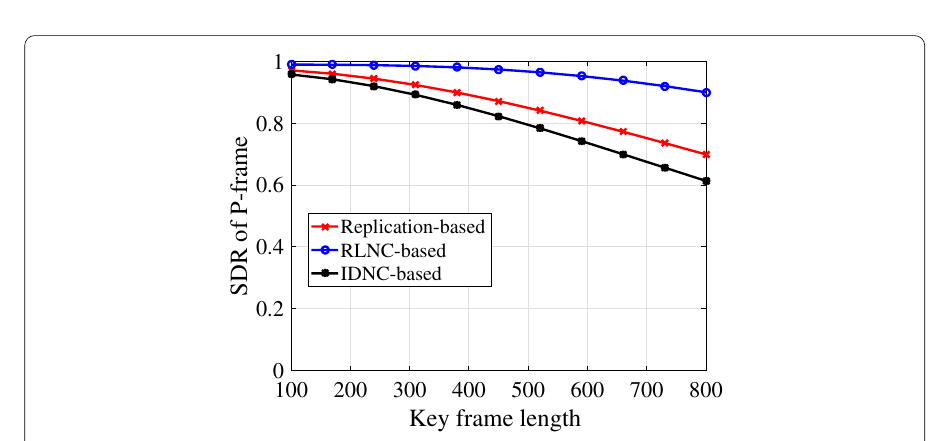
Fig. 7 The impact of keyframe on the SDR of